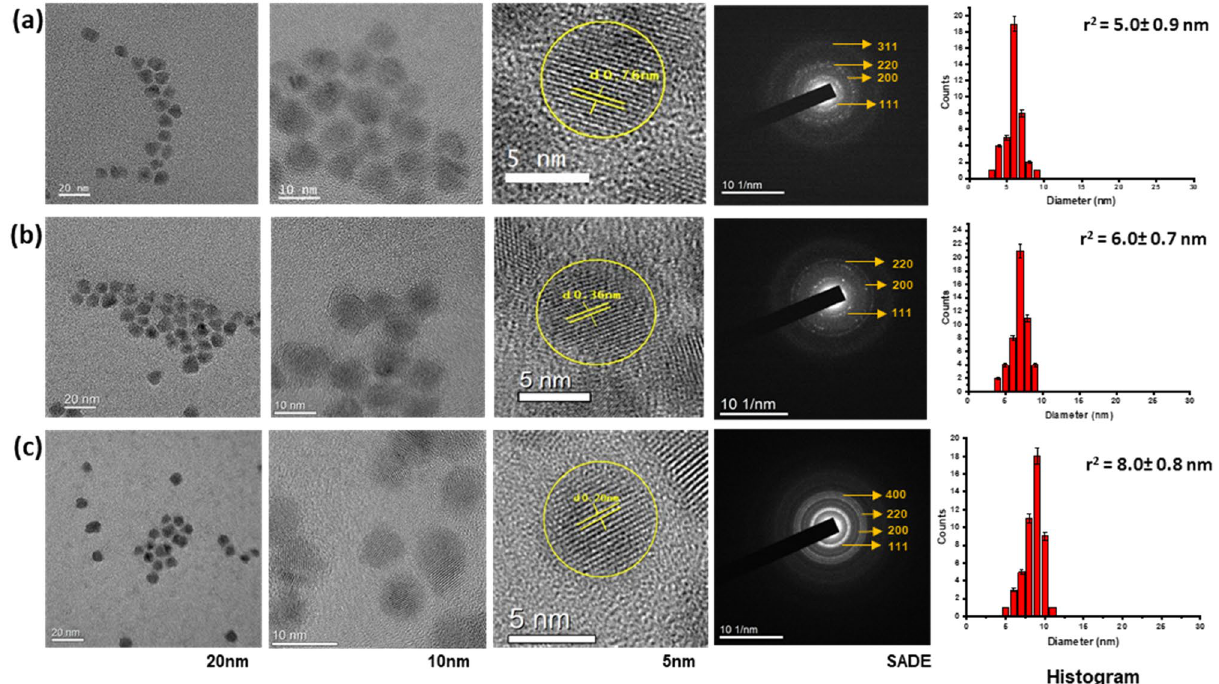
Figure 1. Transmission electron microscopy, selected area electron diffraction and dynamic light scattering images of Quantum dots dispersed in n-Hexanes, images are represented from left to right with enhanced resolutions from 20 to 5 nm ( a ) QD